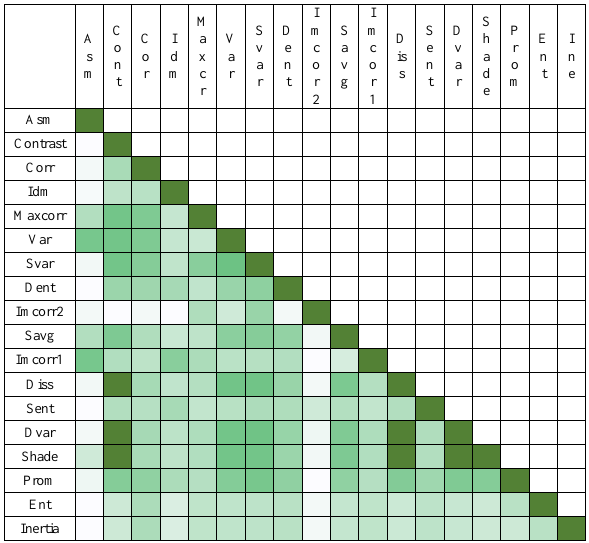
Table 6. Correlation analysis of textural and edge-detector features. The dark green cells indicate a coefficient